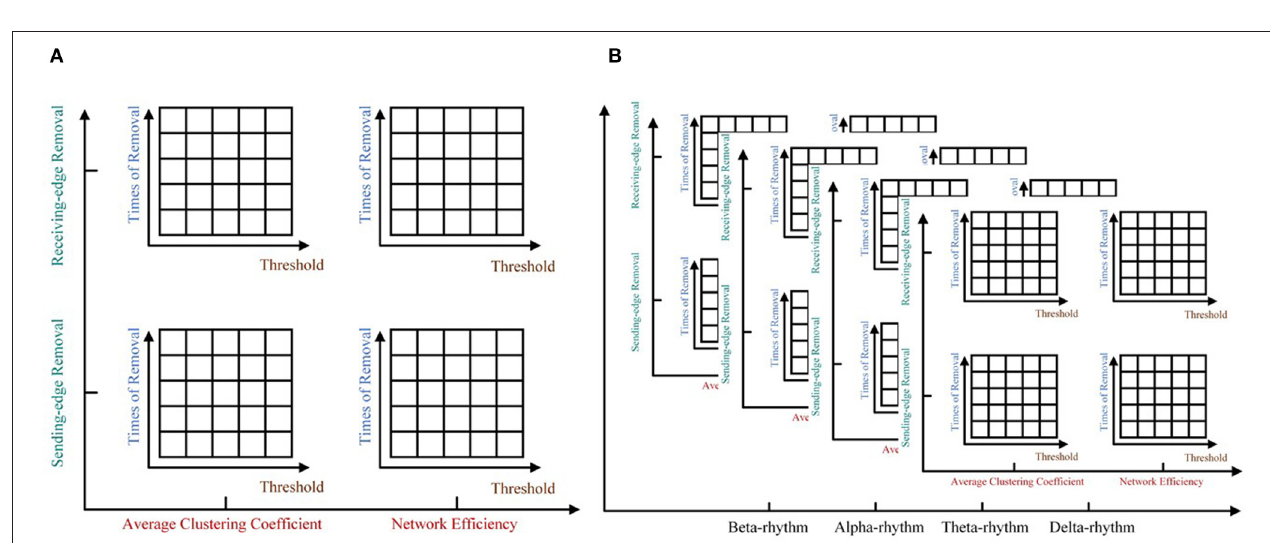
FIGURE 6 | The five-way feature tensor. (A) The average clustering coefficient and the network efficiency can be calculated respectively based on different threshold values, different times of edge removal and different edge removal sub-methods. (B) The five-way feature tensor of brain networks.